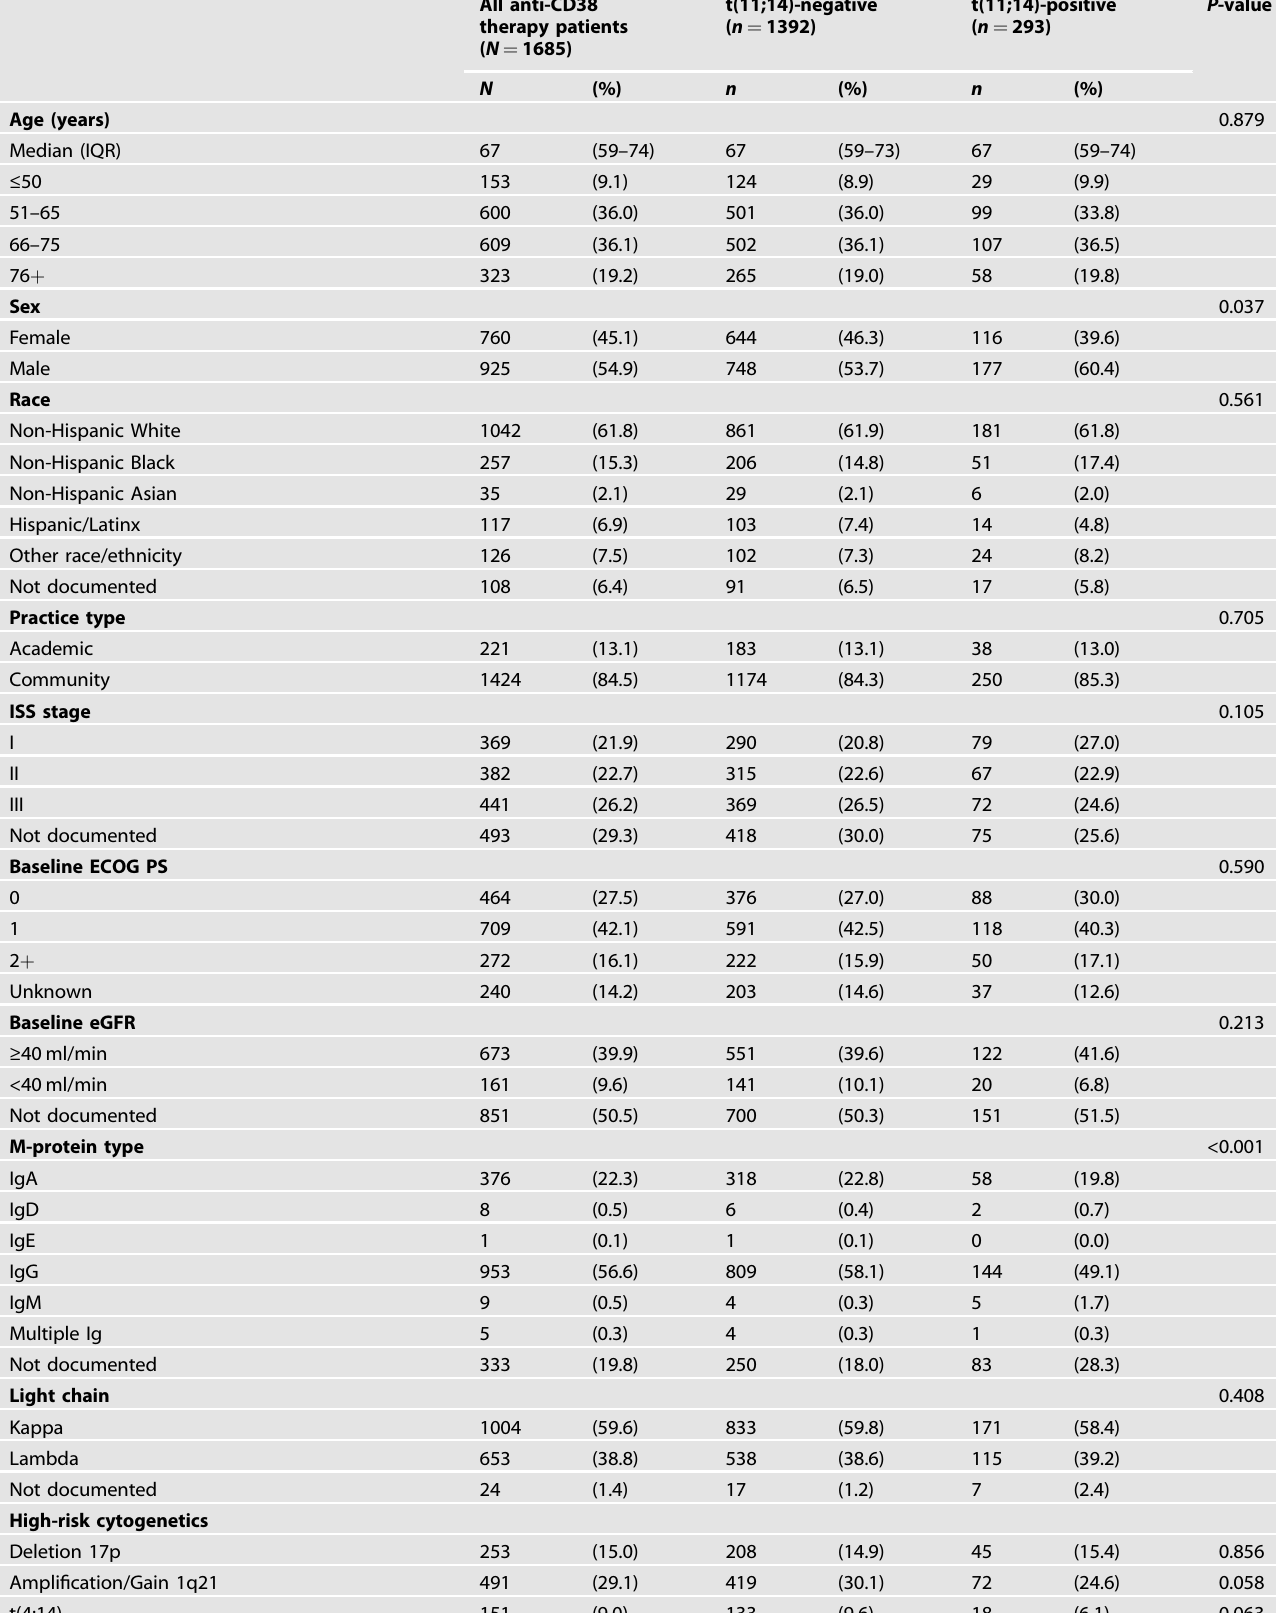
Table 1. Descriptive characteristics of multiple myeloma patients initiating daratumumab- or isatuximab-based lines of therapy by t(11;14) status. All anti-CD38 therapy